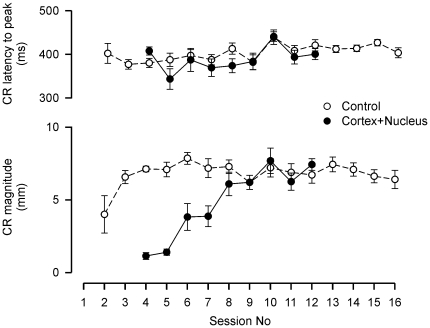
Conditioned response profiles.Mean (±1 SEM) CR latency to peak, and magnitude (amplitude above threshold of 0.5 mm), in Control and Cortex+Nucleus subjects.